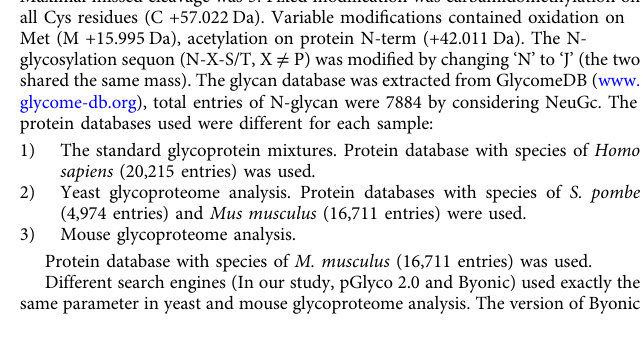
Yeast glycoproteome analysis. Protein databases with species of S. pombe (4,974 entries) and Mus musculus (16,711 entries) were used. Mouse glycoproteome analysis. Protein database with species of M. musculus (16,711 entries) was used. Different search engines (In our study, pGlyco 2.0 and Byonic) used exactly the